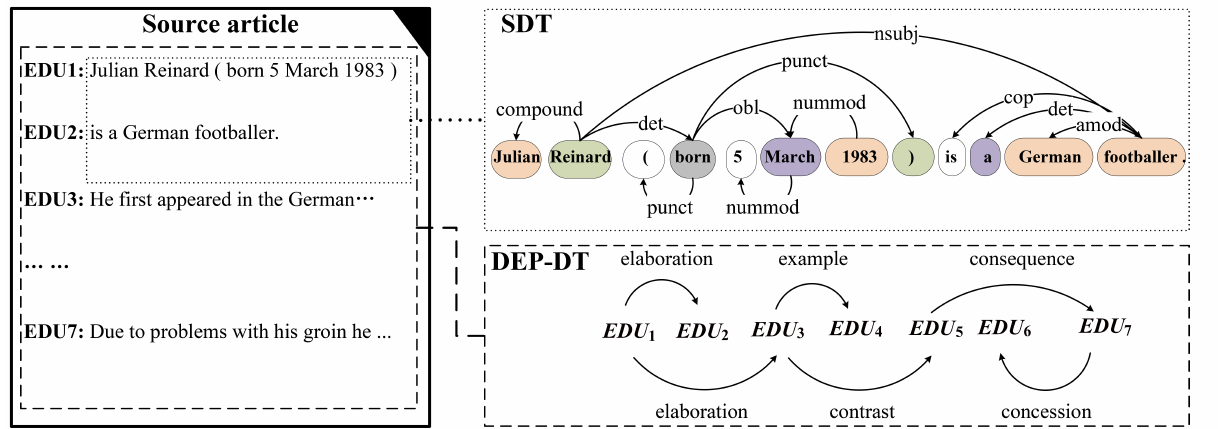
Fig. 3 Example of SDT and DET-DT, which are parsed from a sentence or the whole document. For any document, each sentence has an SDT, but just with one